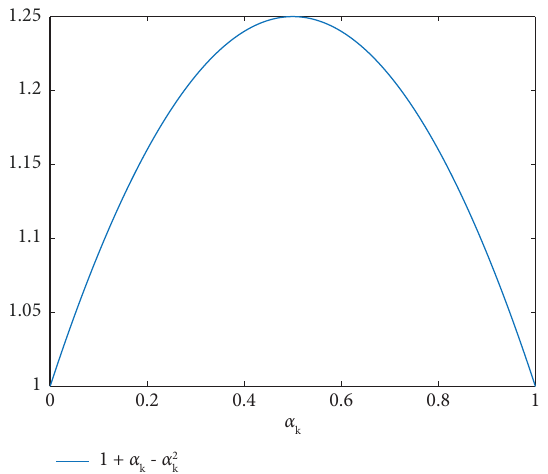
Figure 1: Te graph of the function ℷ ( α